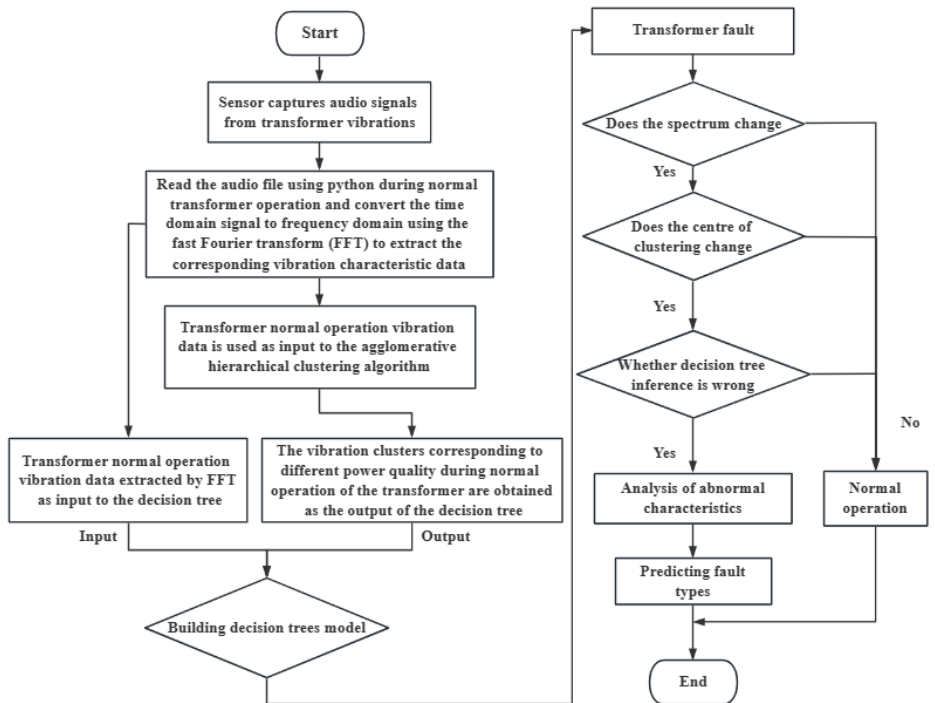
Figure 7. Analysis of transformer fault early warning model.